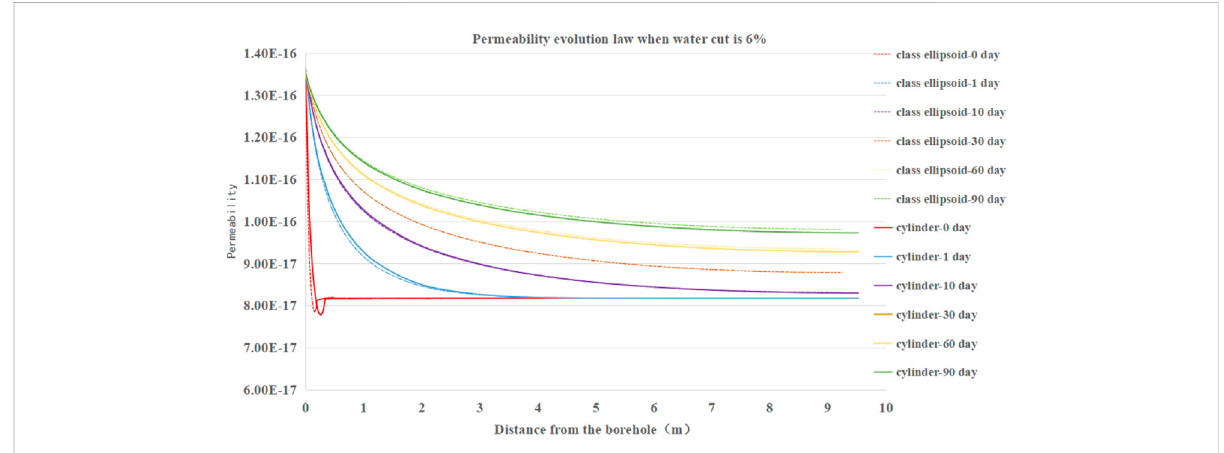
FIGURE 13 Permeability evolution under different pore morphology when water content is 6%.